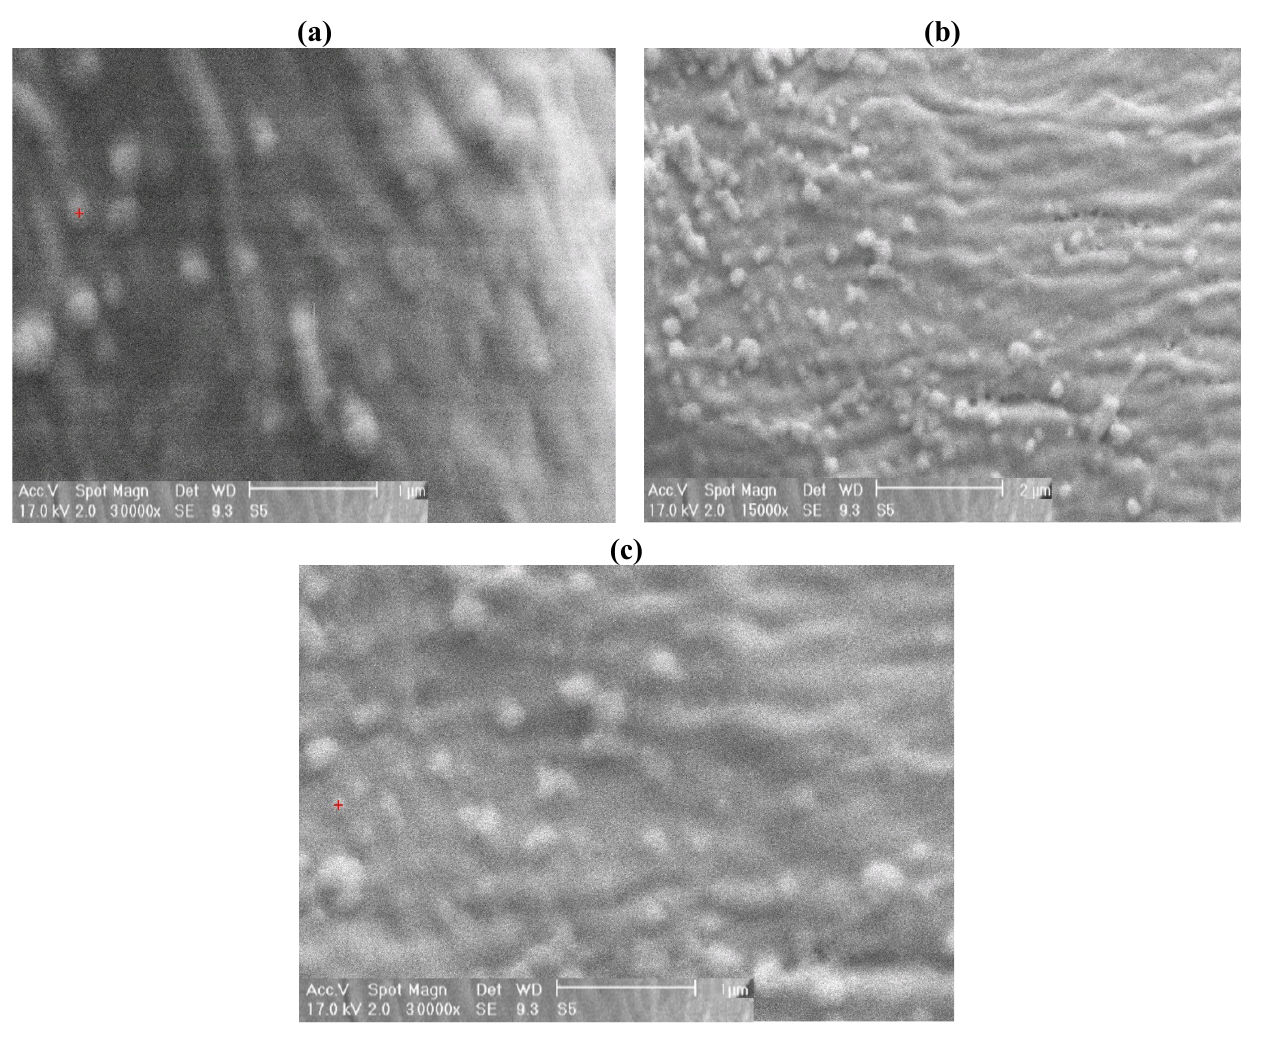
Figure 5. SEM micrographs of (a) silver nanoparticles on untreated cotton; (b) laser treated at 100W, 100cm/s, magnification of 15,000; (c) laser treated at 100 W, 100cm/s and magnification of